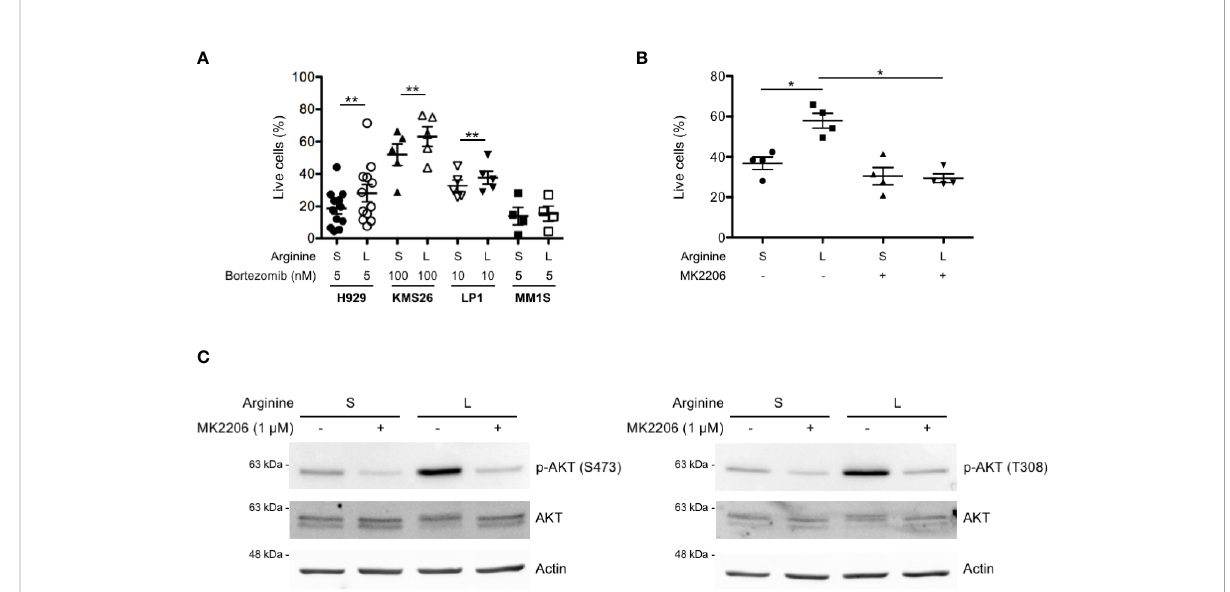
FIGURE 4 Partial arginine deprivation reduces bortezomib-induced cell death in MM cells by increasing AKT phosphorylation. (A) MM cell lines were cultured in complete medium containing standard (S) or low (L) arginine concentration, as in previous fi gures. After 8 h, cells were treated with the indicated doses of bortezomib for 16 h and stained with fl uorescent Annexin V and propidium iodide. Dead and apoptosis-committed cells were identi fi ed by fl ow cytometry and percentages of live cells represented as scatter plots (mean values, n ≥ 4 independent experiments). **p<0.01, paired t-test. (B) H929 cells were cultured in different arginine concentrations, as above, and treated with the AKT inhibitor MK2206 (1 µM) or left untreated. After 8 h, cells were treated with bortezomib (2.5 nM) for 16 h and stained with fl uorescent Annexin V and propidium iodide. Dead and apoptosis-committed cells were counted by fl ow cytometry and live cell percentages represented as scatter plots (mean values, n = 4 independent experiments). *p<0.05, paired t-test. (C) Representative immunoblot analyses showing expression of total and phosphorylated AKT at serine 473 (left panel) and at threonine 308 (right panel) after 24 h of culture in S or L arginine concentrations in H929 cells treated with MK2206 (1 µM) or left untreated. Actin B serves as loading